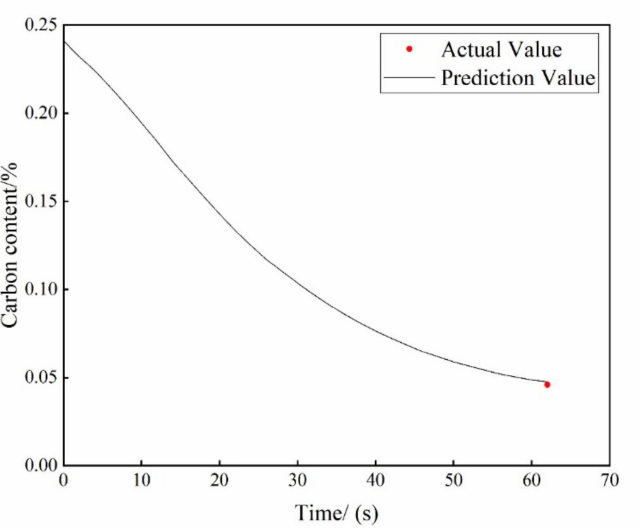
Figure 12. Prediction results of the application